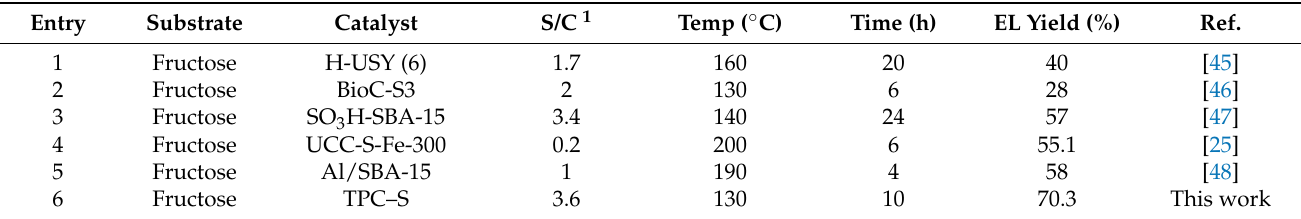
Table 2. A comparison of the catalytic performance with previous